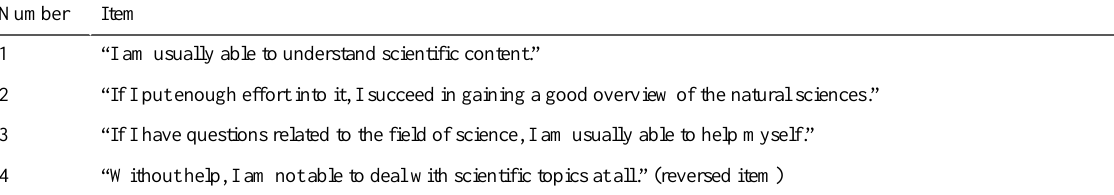
Table 1. Items measuring academic self-efficacy.